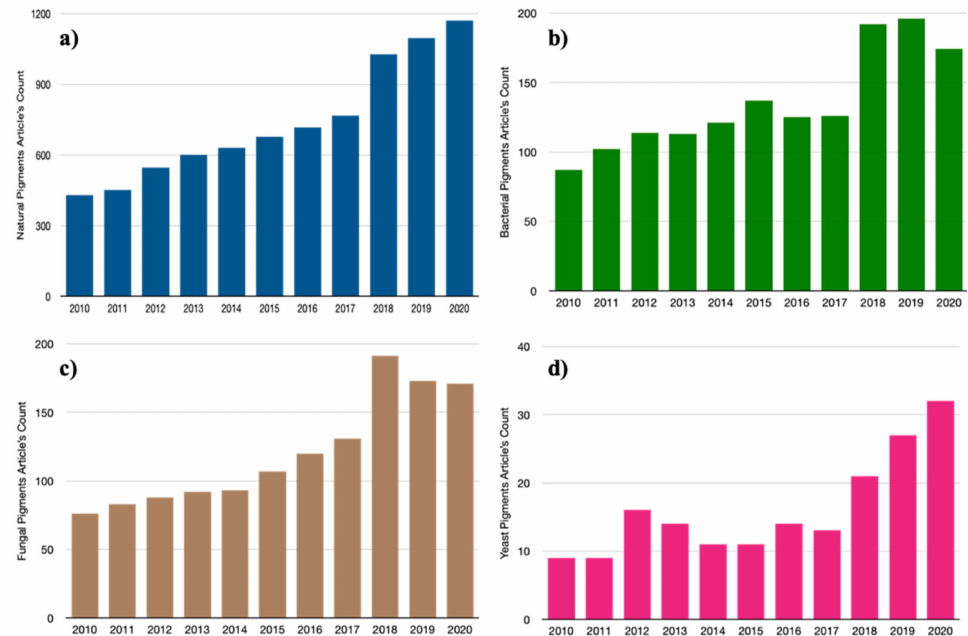
Figure 1. The articles indexed in NCBI database related to ( a ) “Natural pigments”; ( b ) “Natural Pigments and Bacteria”; ( c ) “Natural Pigments and Fungi”; ( d ) “Natural Pigments and Yeast” trends in the last 10